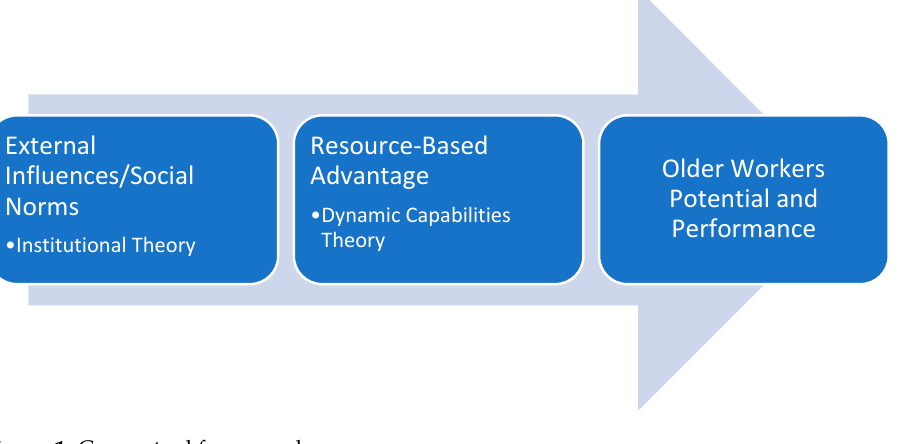
Figure 1. Conceptual framework.